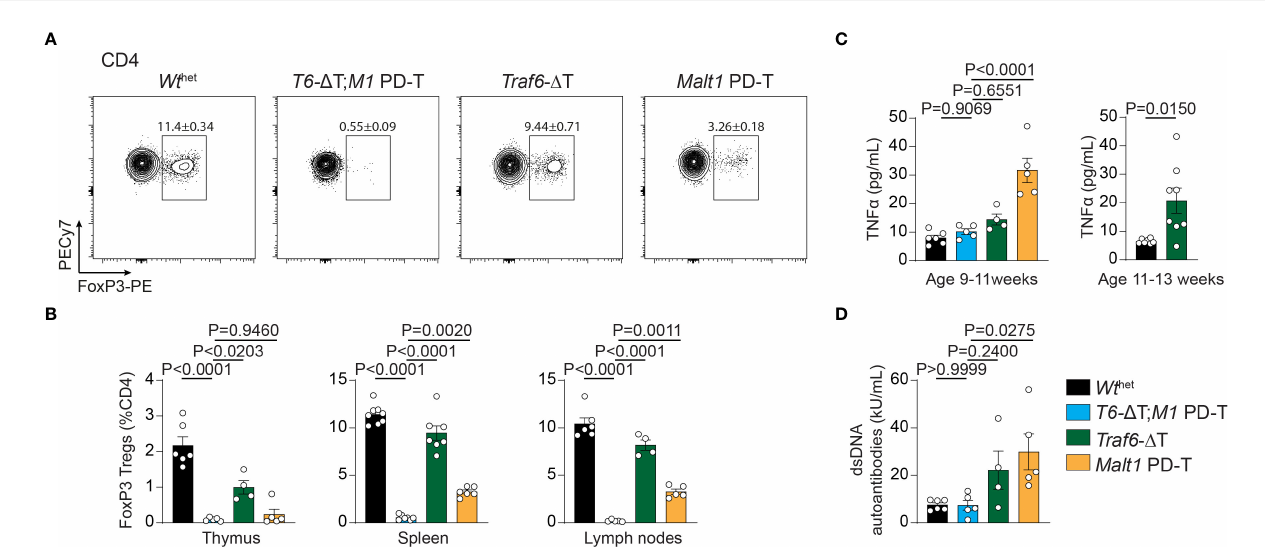
FIGURE 3 Effects of single or combined TRAF6 KO and MALT1 paracaspase mutation on Treg cell frequencies, TNF a and anti-dsDNA autoantibodies. (A, B) Flow cytometric analysis of splenic CD4 + FoxP3 + regulatory T (Treg) cells (A) with relative numbers of Treg cells from thymus, spleen and peripheral lymph nodes (B) of Wt het , T6- D T; M1 PD-T, Traf6 - D T and Malt1 PD-T mice. (C) Concentration of the cytokine TNF a in sera of mice as depicted in (A) . Right graph depicts TNF a concentrations in 11-13 week old Traf6 - D T mice. (D) Concentrations of anti-dsDNA immunoglobulins in sera of mice as depicted